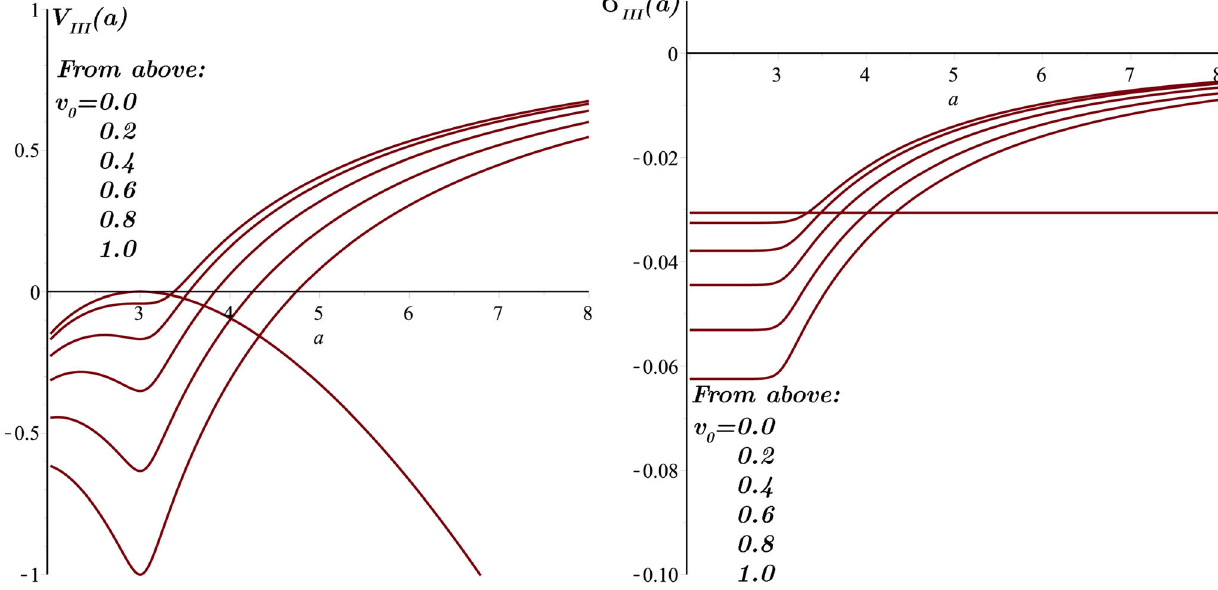
= 0 . 0 , 0 . 2 , 0 . 4 , 0 . 6 , 0 . 8 and 1 . 0. See the caption 0